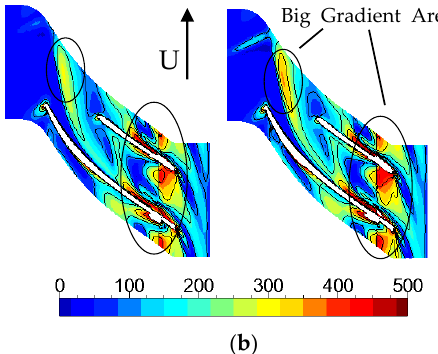
Figure 14. Distribution of the relative Mach number and its gradient at 90% blade span: ( a ) Relative Mach number ( left : plain right : plateau); ( b ) Distribution of the gradient of the relative Mach number ( left : plain right : plateau).